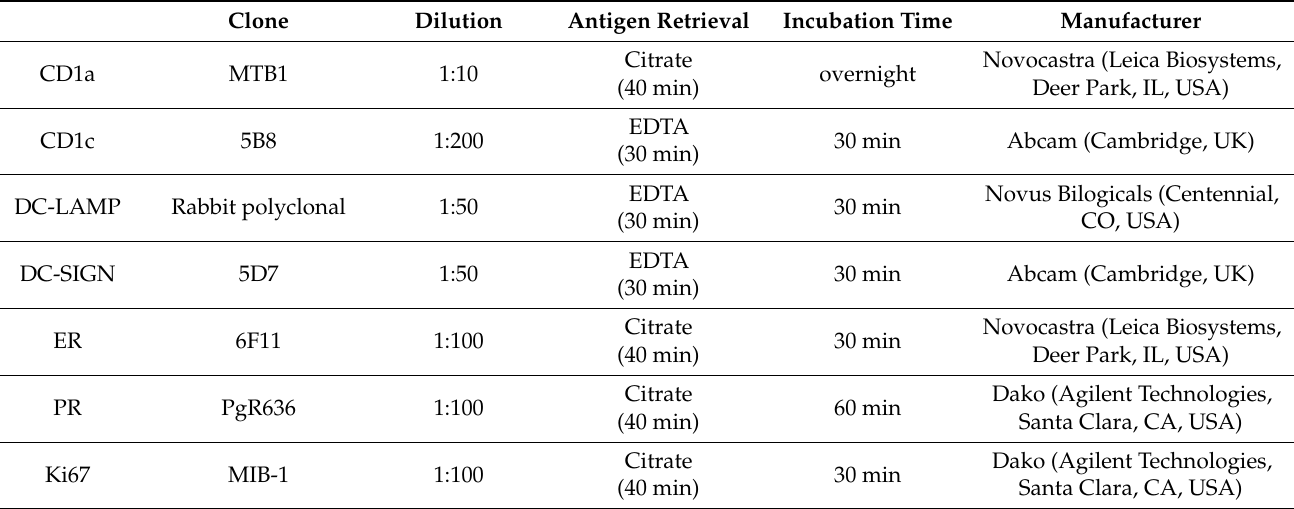
Table 4. Antibodies used in the